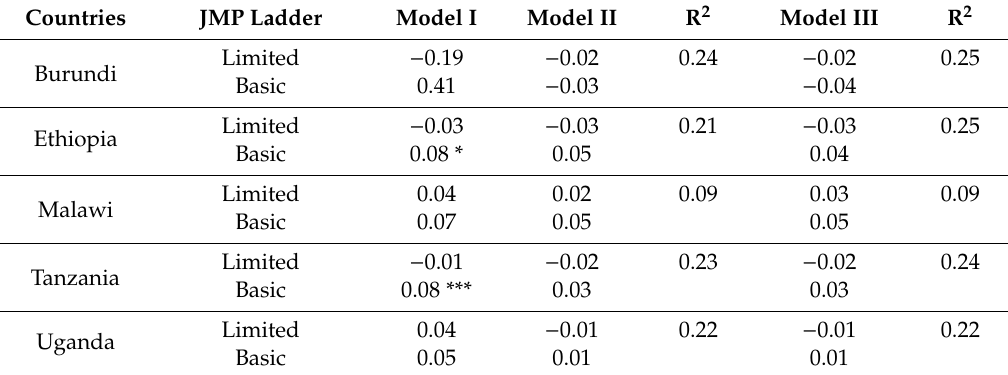
Table 6. Predicted increments in young child LAZ (6–23 mo) associated with JMP hygiene indicators in East